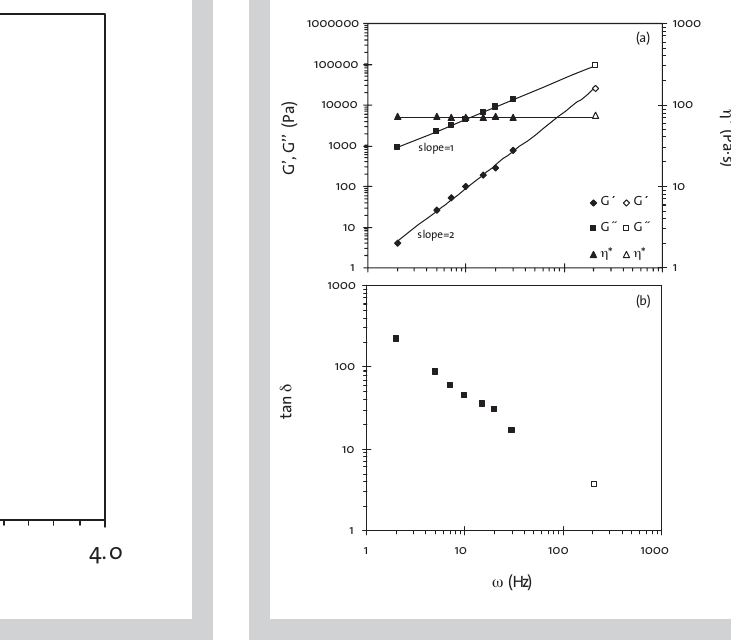
Figure 4 (left): Ratio of the measured force to the inertial force as a function of gap spacing for PB measured using the HF-SPR. Figure 5: a) Storage modulus, G’, loss modulus, G’’, complex vis- cosity, h *, and b) loss tangent,tan d , as a function of angular fre- quency, w , for PB measured on the parallel plate rheometer (filled symbols) and HF-SPR (unfilled sym- bols). Solid lines are linear extrapolations of the low frequency parallel plate data to 210